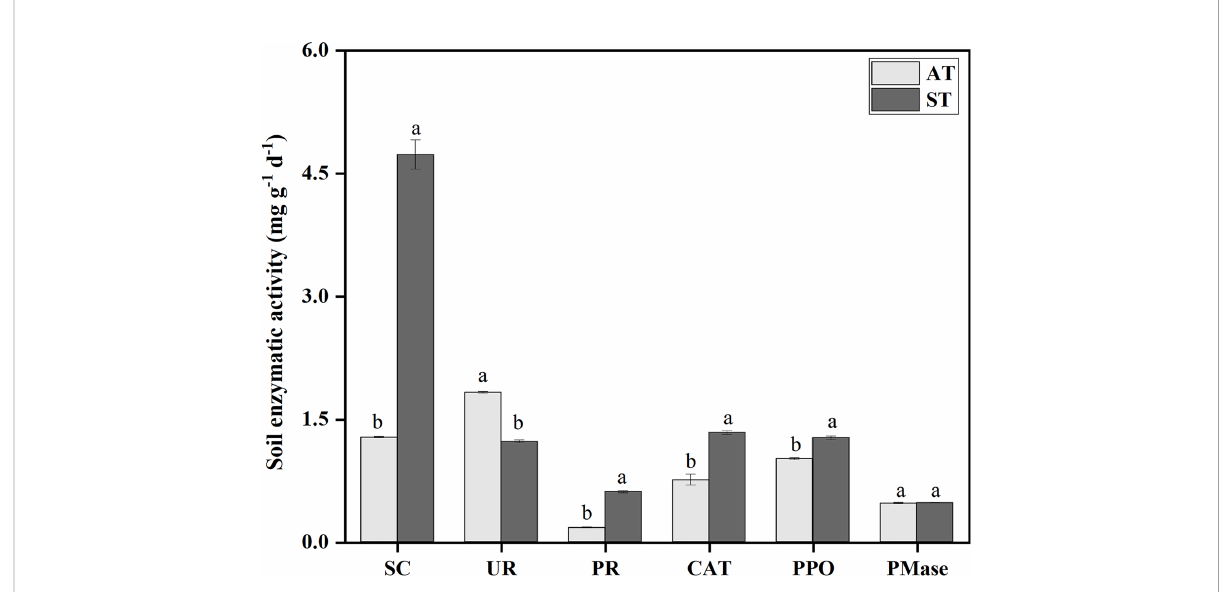
FIGURE 1 Soil enzyme activities in tea soil with different pH values. SC, sucrase; UR, urease; PR, protease; CAT, catalase; PPO, polyhphenol oxidase; PMase, phosphomonoesterase. AT, tea soil with a pH of 3.75; ST, tea soil with a pH of 5.26. Bars indicate standard error of the mean (n = 3). Different lowercases represent signi fi cant differences at P < 0.05 level.